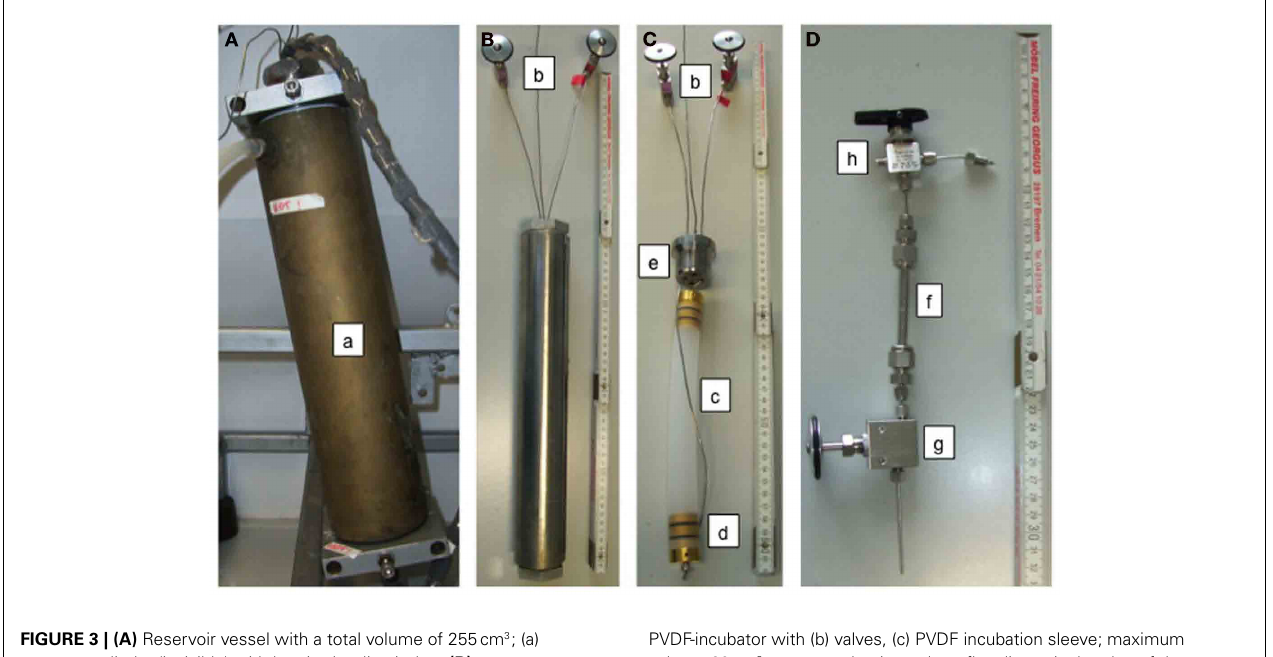
FIGURE 3 | (A) Reservoir vessel with a total volume of 255cm 3 ; (a) pressure cylinder (invisible) with heating/cooling jacket; (B) high-pressure reaction vessel including connections with (b) valves for in- and out-flow of medium via the incubator; the third line (without a valve) is for the application of pressure to the reaction vessel; (C)